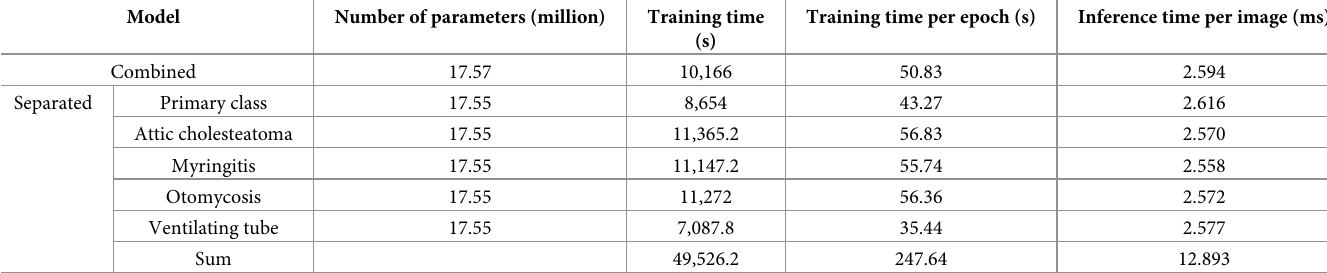
Table 3. Computational cost and inference time for application of deep-learning classification for tympanic membrane changes.